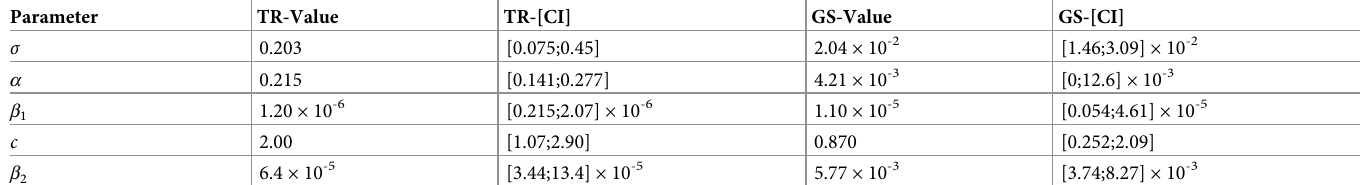
Table 6. Single infections: Estimated values and 90% confidence intervals (CI) for the parameters of the selected model (M12) for T. retortaeformis (TR) and G. stri- gosum (GS). The 90% CIs are estimated via